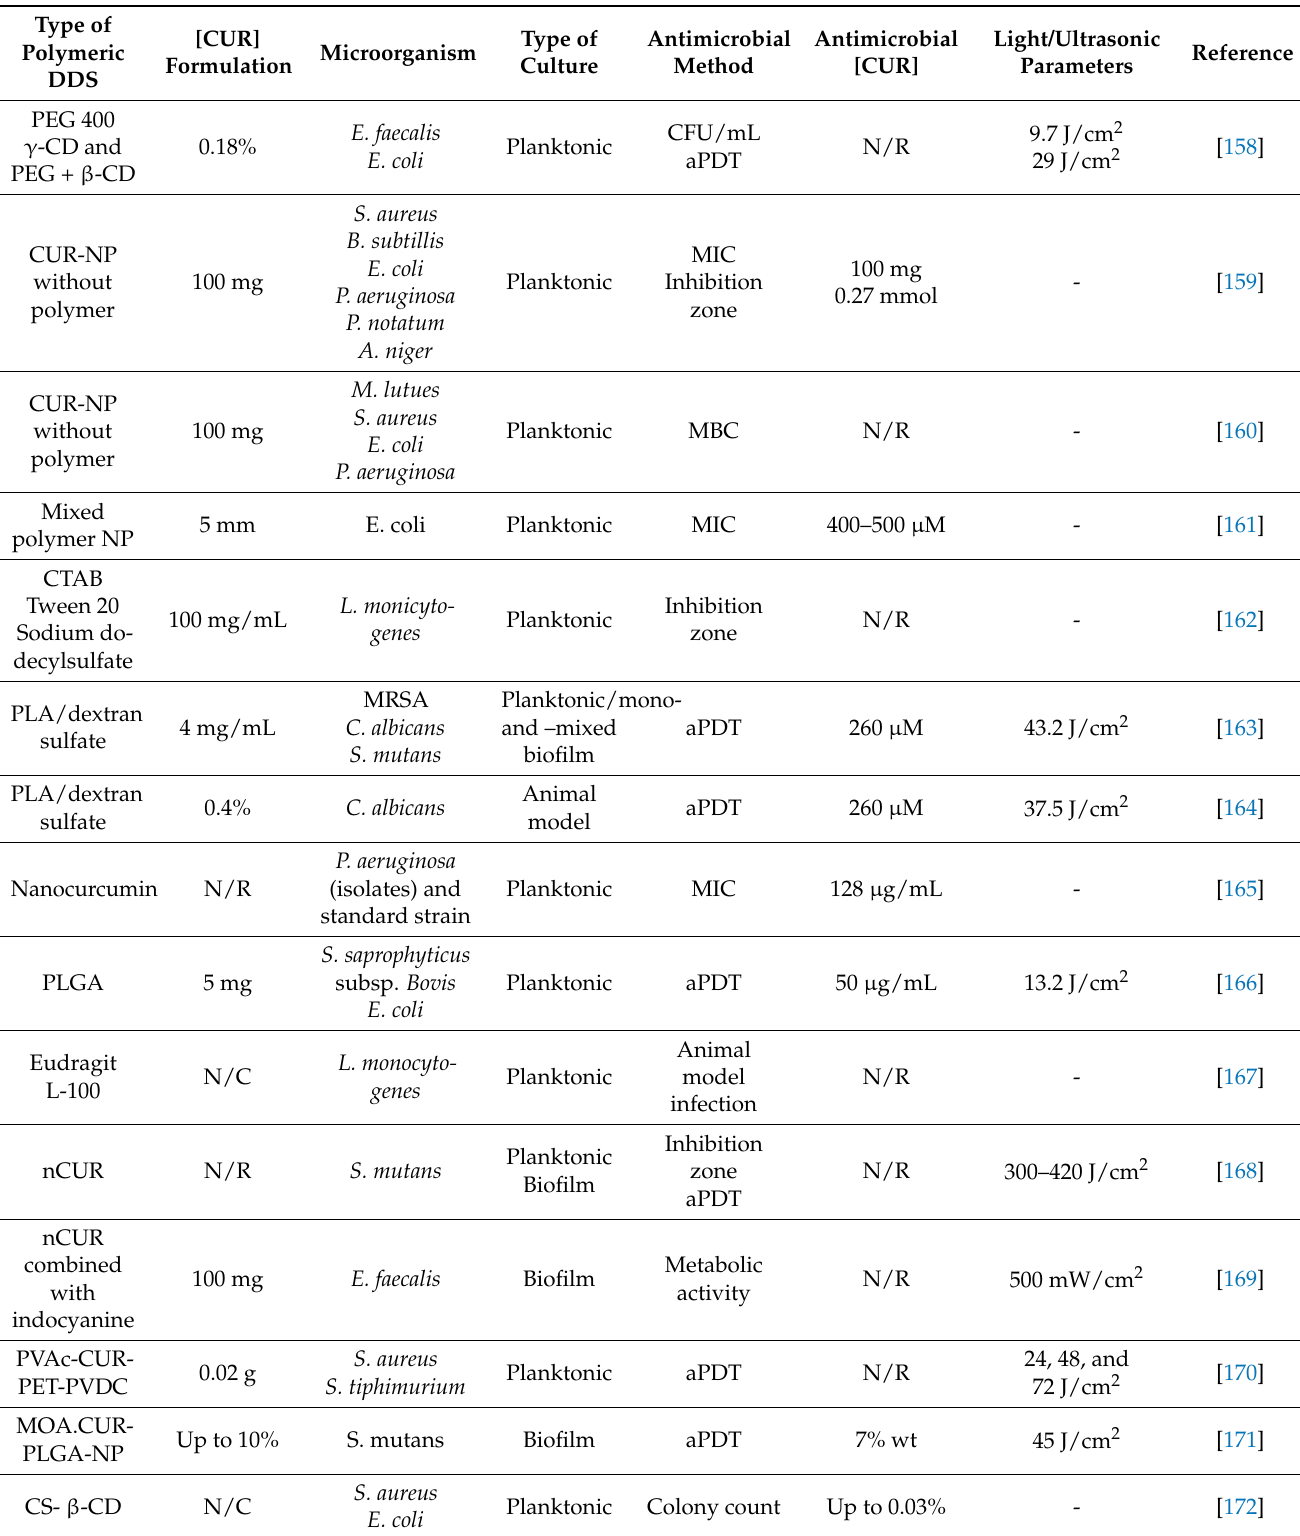
Table 7. Antimicrobial studies performed with curcumin in polymeric drug delivery